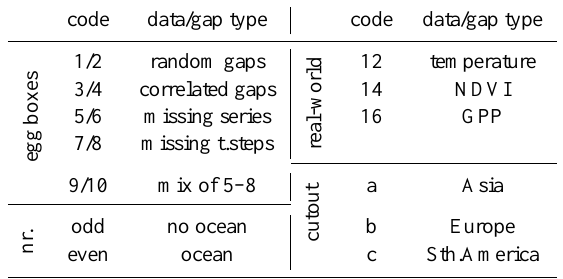
Table 2. Overview of datasets and gap scenarios used for testing the gapfilling method.